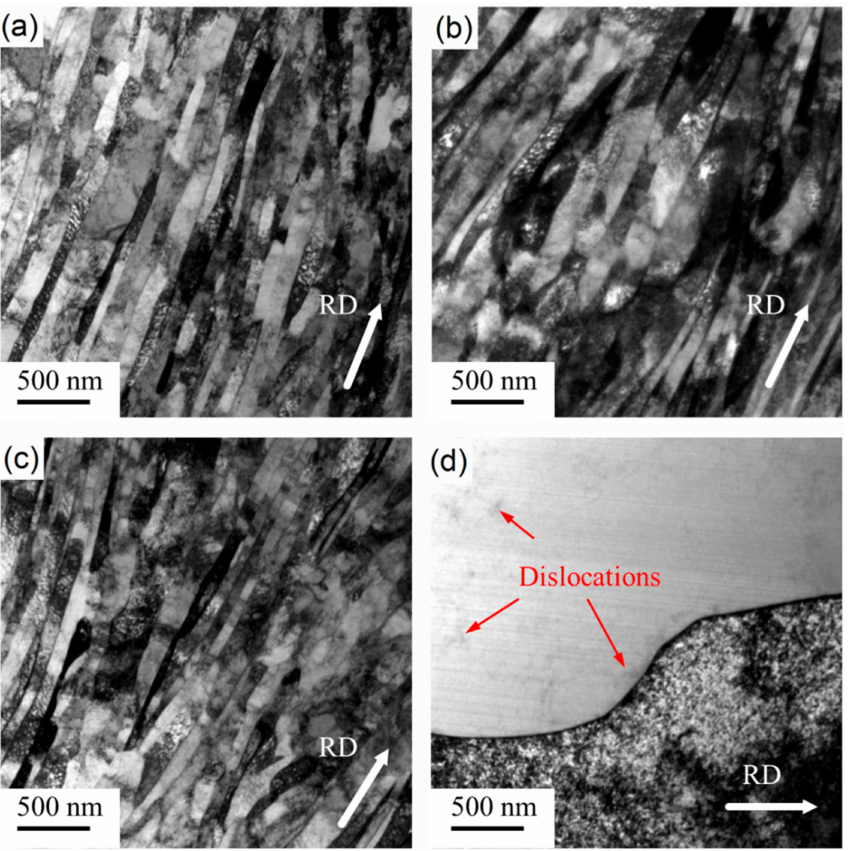
Figure 1. TEM images of Ni sheets subjected to ( a ) room-temperature rolling and subsequent annealing at ( b ) 75 ◦ C, ( c ) 160 ◦ C, and ( d ) 245 ◦ C for 1